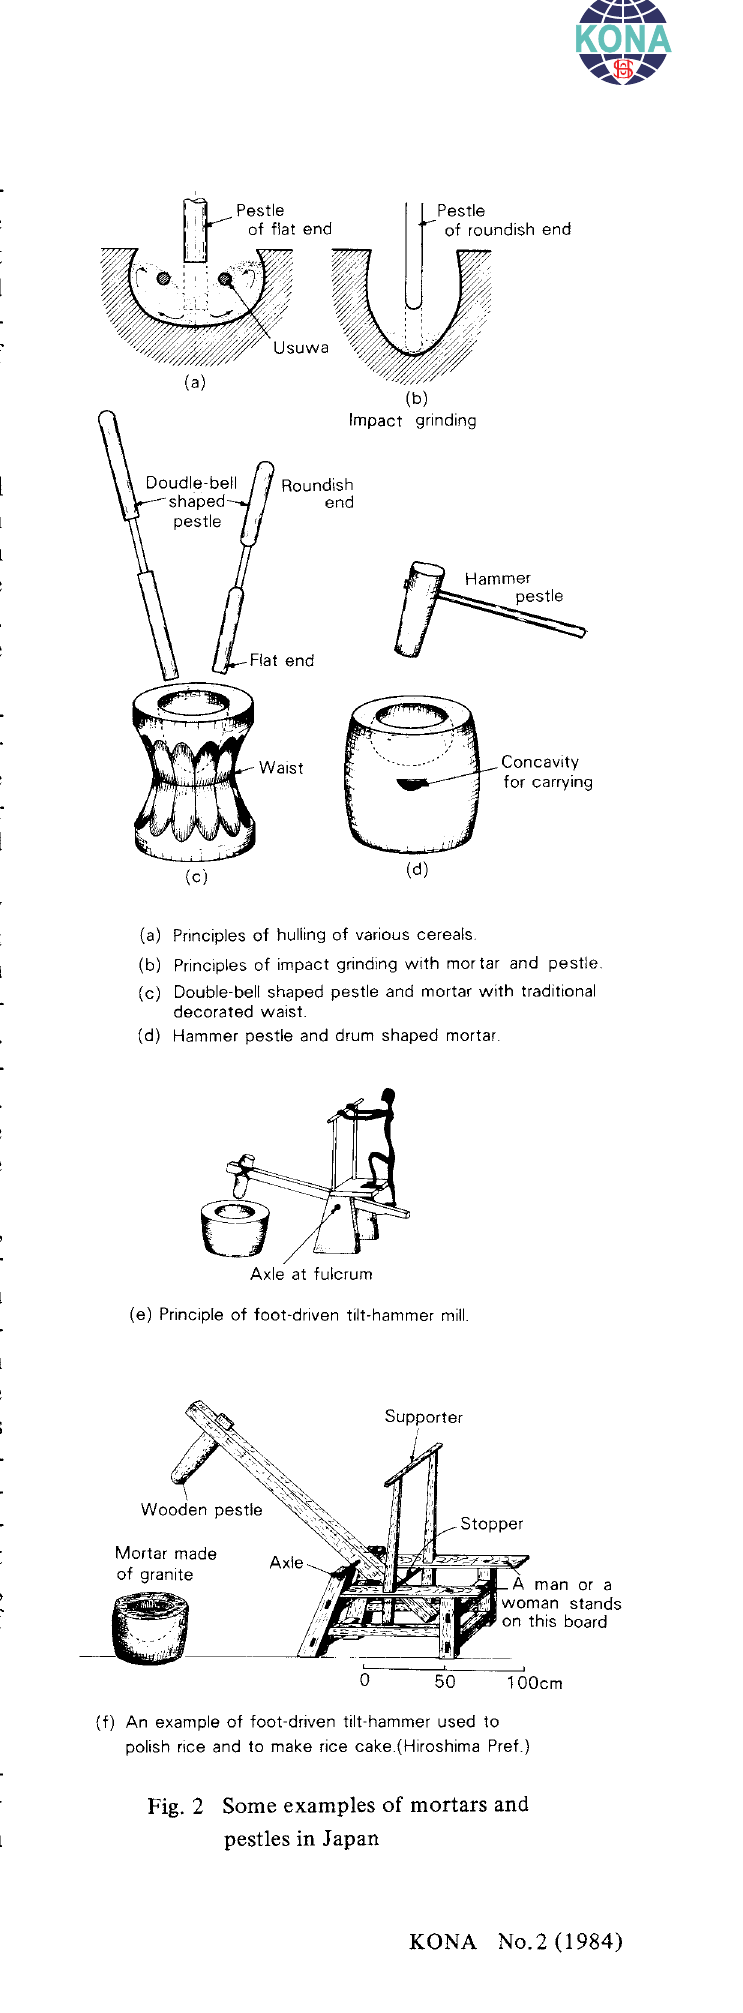
Fig. 2 Some examples of mortars and pestles in